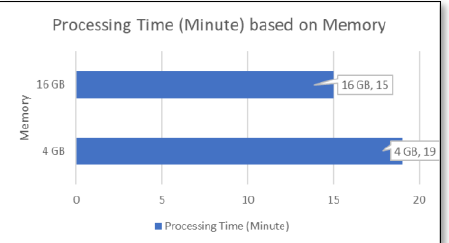
Figure 9: Comparison between processing time based on memory.